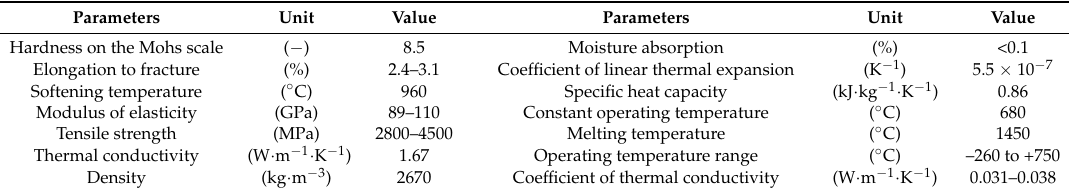
Table 4. Parameters of basalt fibres